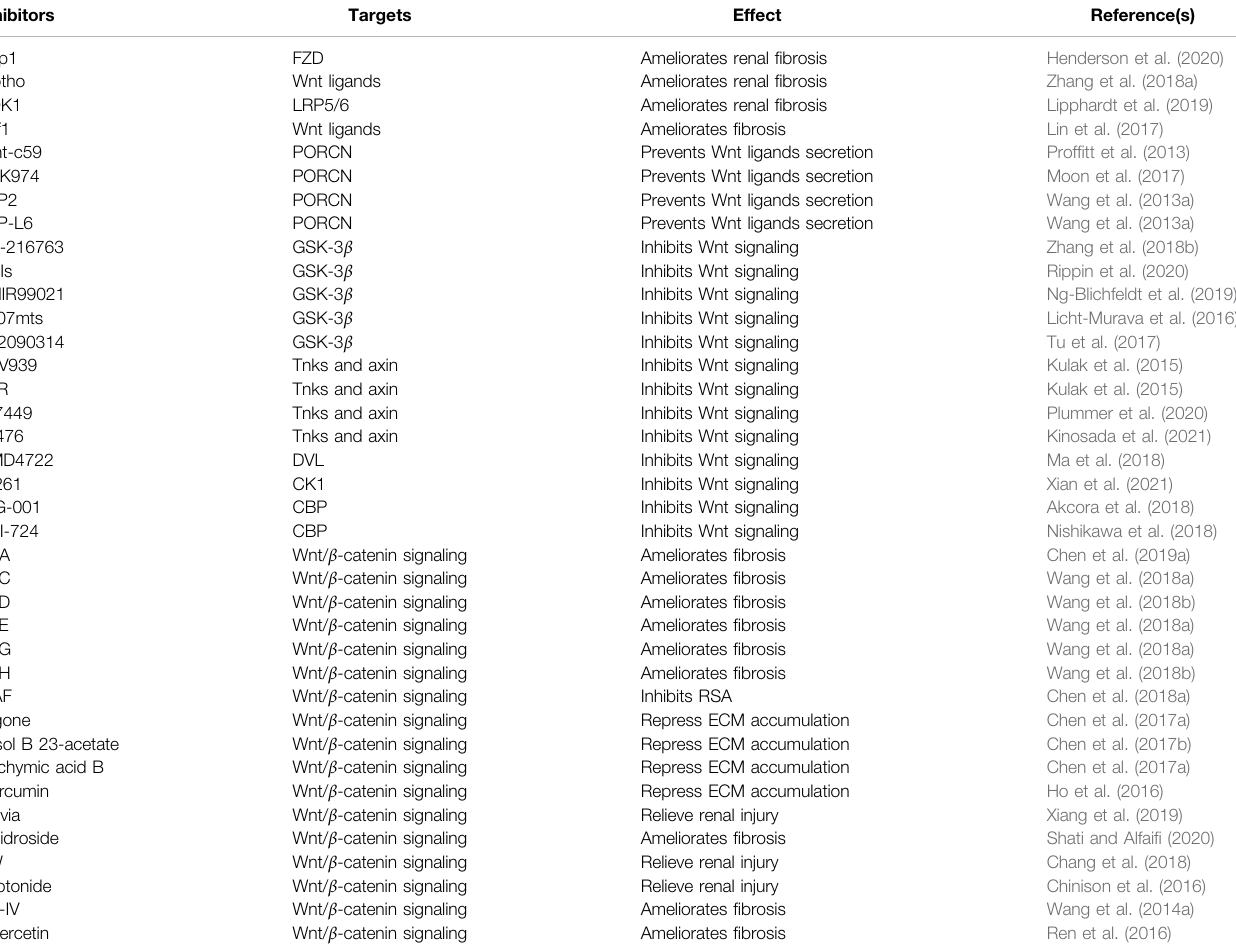
TABLE 1 | Summary of small molecular inhibitors of Wnt/ β -catenin signaling.